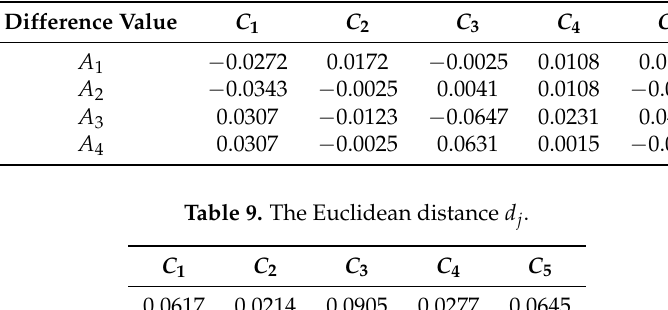
Table 8. The difference between the weighted decision matrix and its negation matrix.